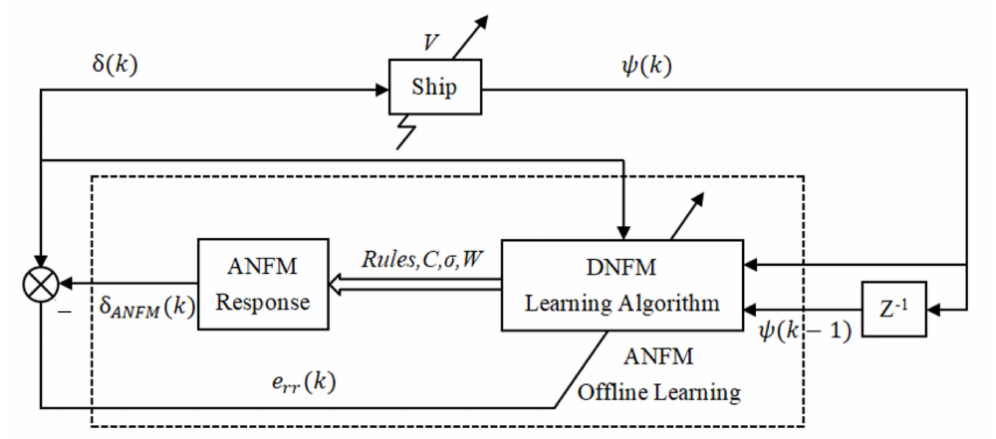
Figure 5. Progress of ANFM